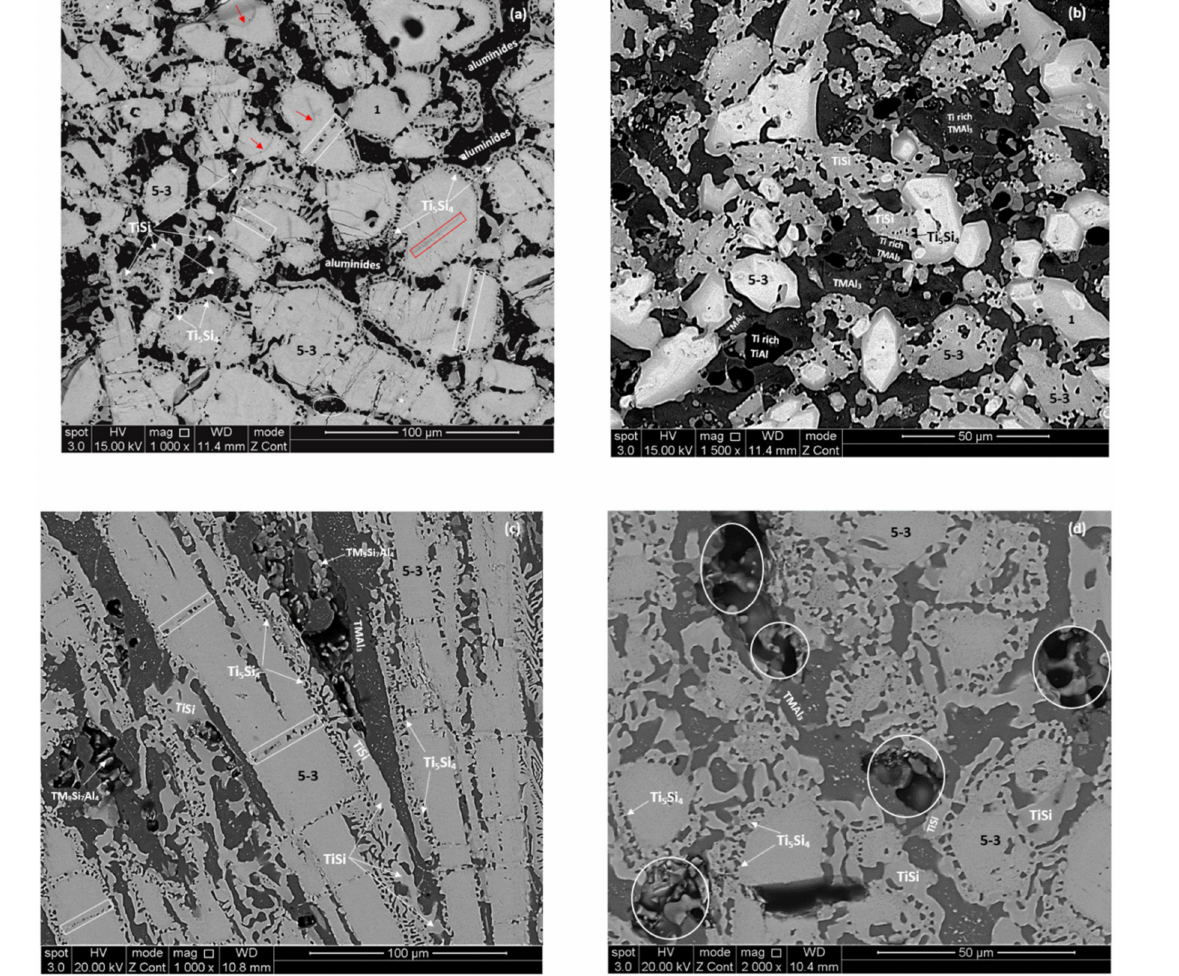
Figure 6. BSE images of the microstructures of the heat treated alloys at 1200 ◦ C ( a ) and ( b ) MG5, ( c ) and ( d ) MG6. In (b) the contrast of the image has been enhanced in order to show the different contrasts of aluminides formed between the γ Nb 5 Si 3 grains. In (d) the circles indicate areas where incipient melting had